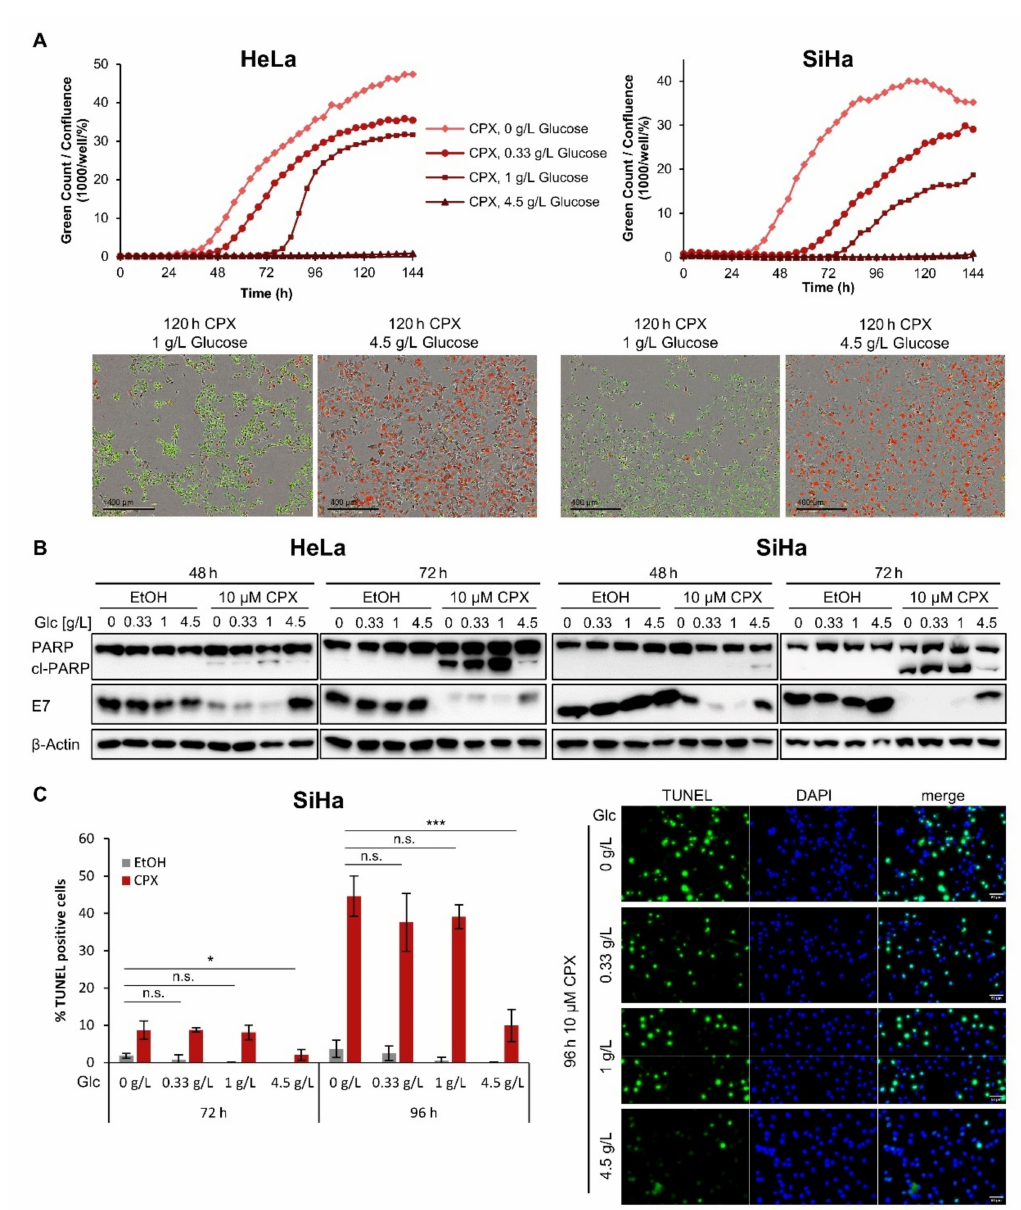
Figure 2. Increased glucose availability protects cells against CPX-induced apoptosis. ( A ) For the quantification of cell death, HeLa mKate2 or SiHa mKate2 cells were treated for up to 144 h with 10 µ M CPX under the indicated glucose levels